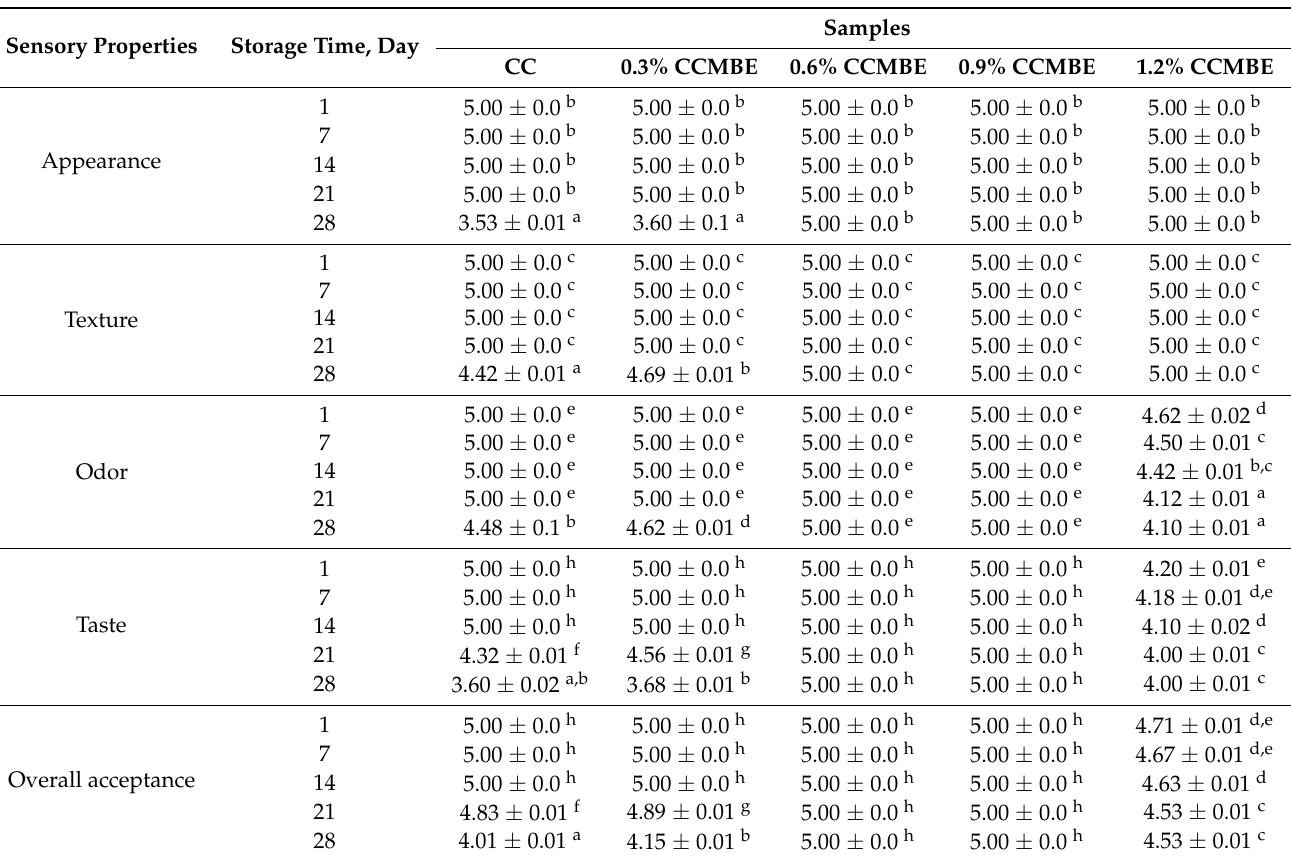
Table 4. Sensory properties’ (score) evolution in cream cheese fortified with microencapsulated basil extract, during